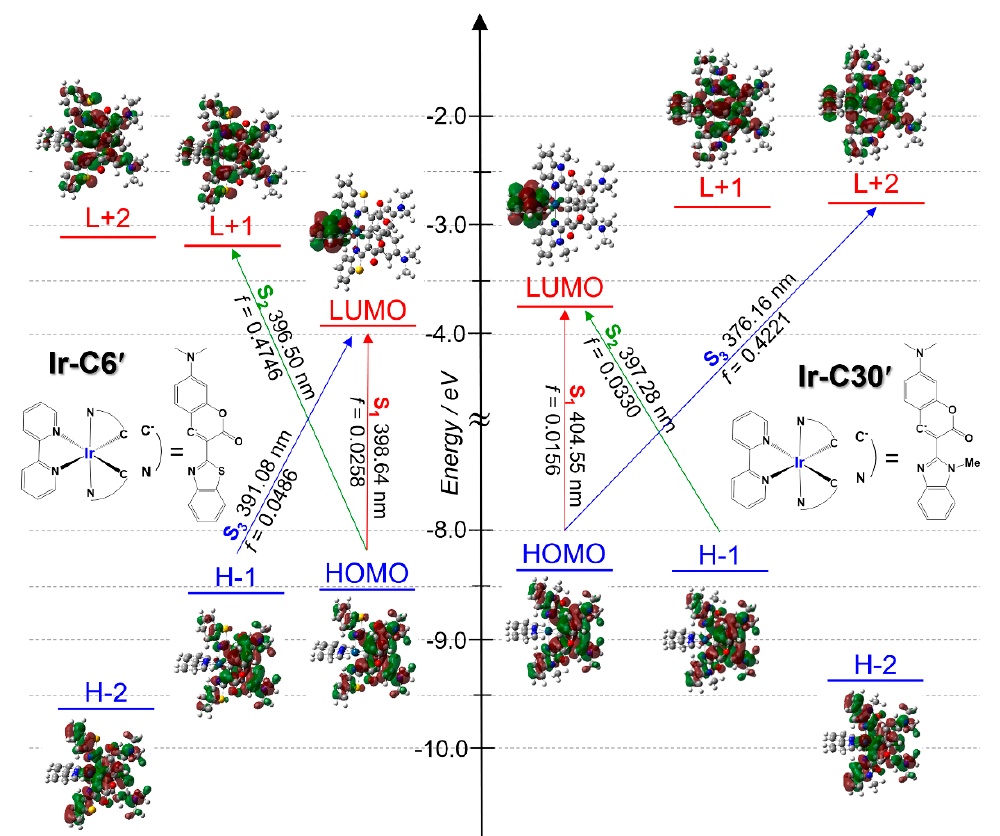
Figure 4. Schematic energy diagram and molecular orbital shapes of the simplified Ir(III)-coumarin complexes, Ir-C6 ′ and Ir-C30 ′ , estimated by time-dependent density-functional-theory (TD-DFT) calculation. Red, green, and blue arrows schematically indicate the primary contribution for the spin-allowed first, second, and third lowest-energy electronic transitions (S 0 to S 1 , S 2 , and S 3 , respectively). The wavelength and oscillator strength of each transition are also shown.